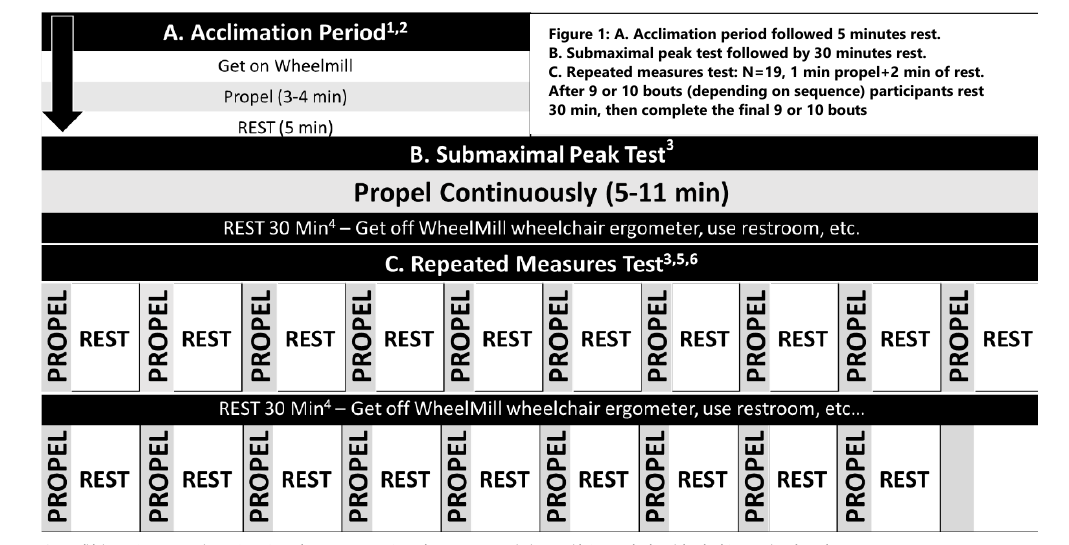
Figure 1: A. Acclimation period followed 5 minutes rest. B. Submaximal peak test followed by 30 minutes rest. C. Repeated measures test: N=19, 1 min propel+2 min of rest. After 9 or 10 bouts (depending on sequence) participants rest 30 min, then complete the final 9 or 10